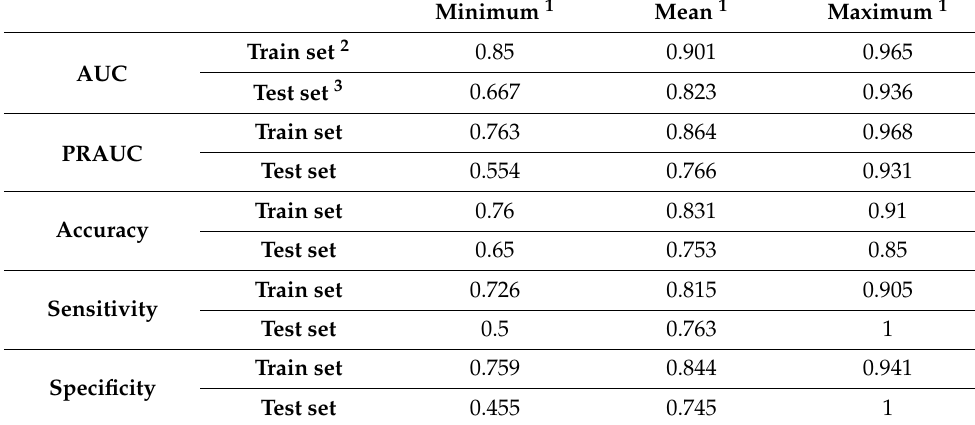
ficity corresponds to true classification of COPD. 5 Sensitivity corresponds to true classification of AC with COPD. Table 3. Metrics for train-test-split validation for the comparison AC vs. COPD.